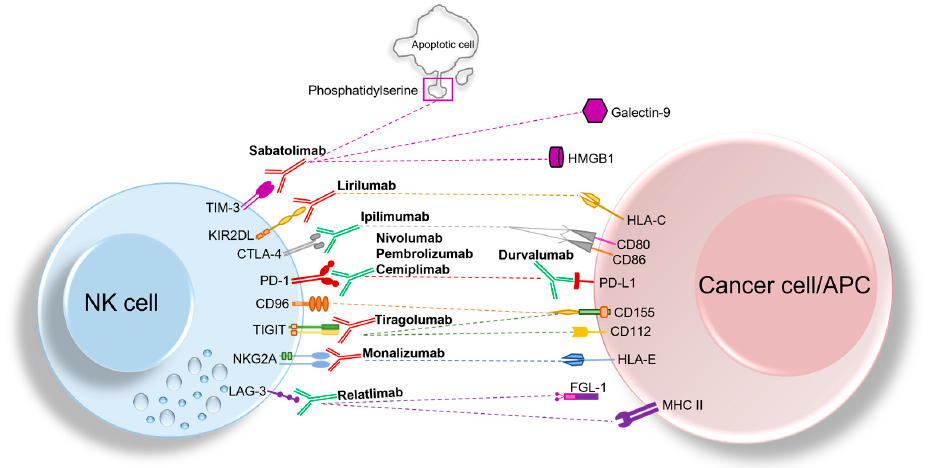
Figure 1. Overview of classical and non-classical ICs expressed by NK cells and their cognate ligands expressed either on cancer cells or antigen-presenting cells (APCs). The blocking mAbs that are currently being investigated in clinical trials, including anti- TIM-3, anti-NKG2A, anti-KIR, and anti-TIGIT mAbs are depicted in red, while blocking mAbs that are approved by FDA and currently used in clinic (such as anti-PD-1, anti-CTLA-4, and anti-LAG-3 mAbs) are represented in green. Blockade of ICs could recover NK cell anti-tumor activity, thereby representing a promising approach for